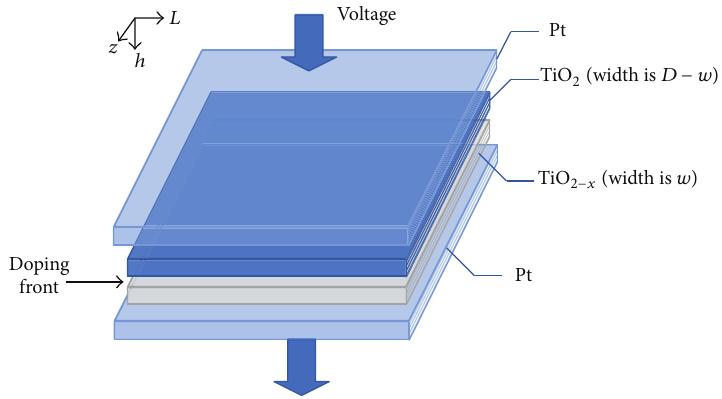
Figure 1: Schematic model of the HP